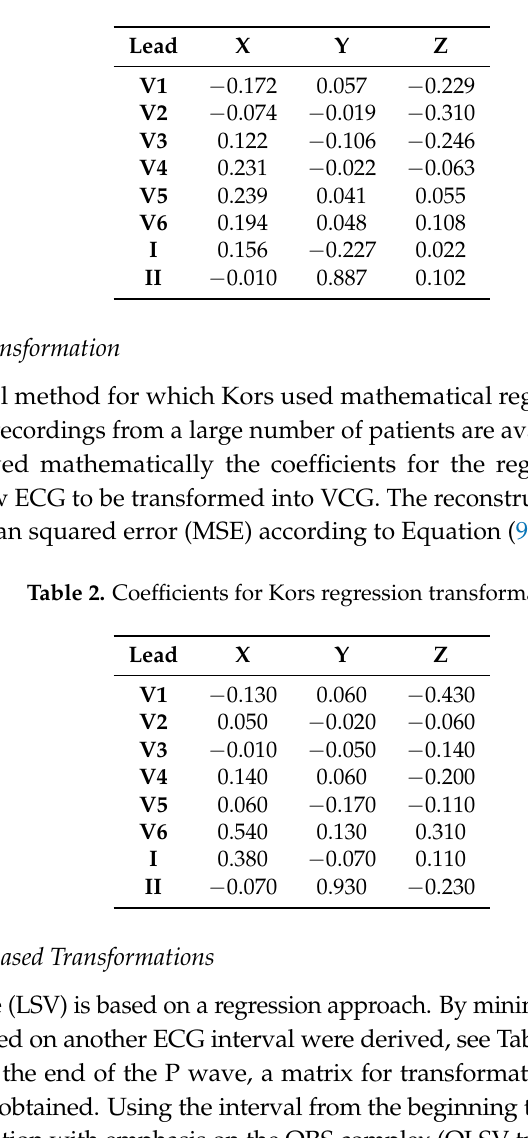
Table 1. Transformation matrix coefficients for inverse Dower transformation.